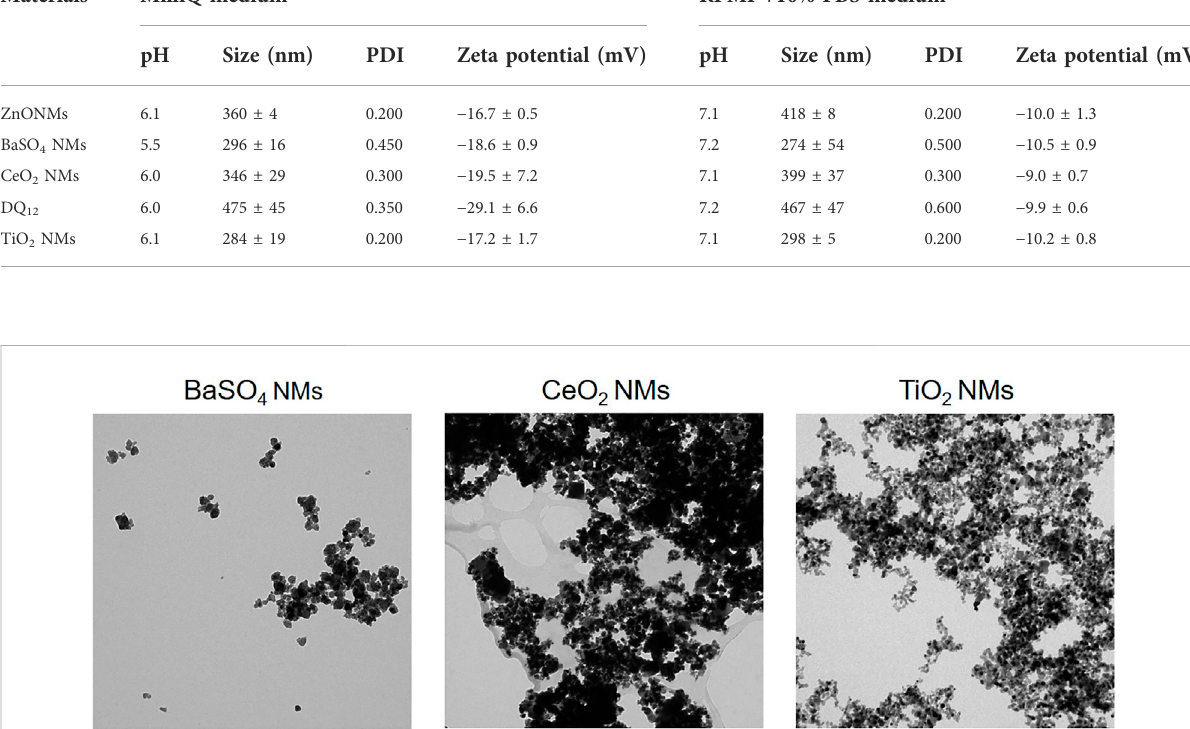
TABLE 1 DLS and ELS measurements of NM stock solutions prepared in MilliQ + BSA and diluted in MilliQ water and RPMI + 10% FBS media at 100 μ g/ml. Materials